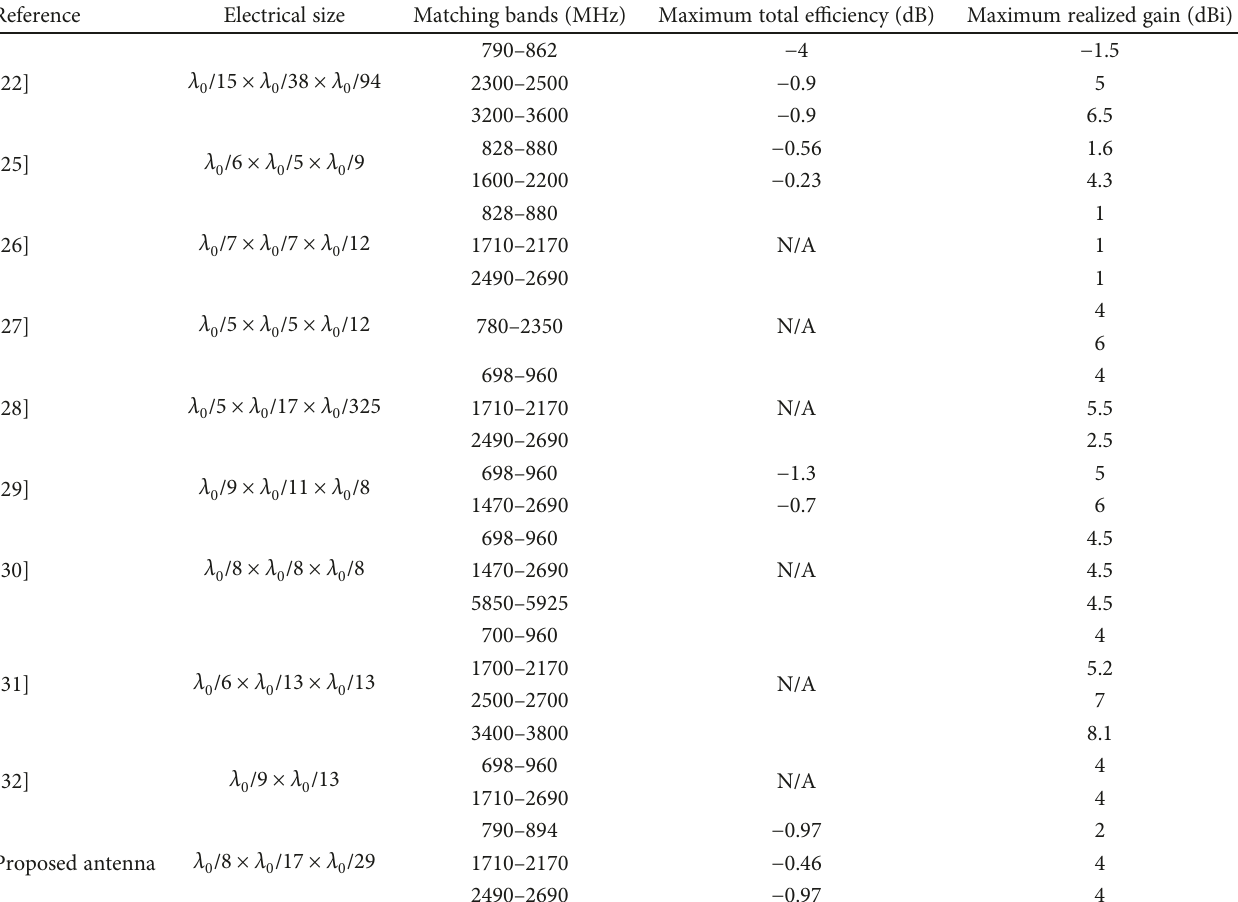
Table 2: Comparison with other studies.